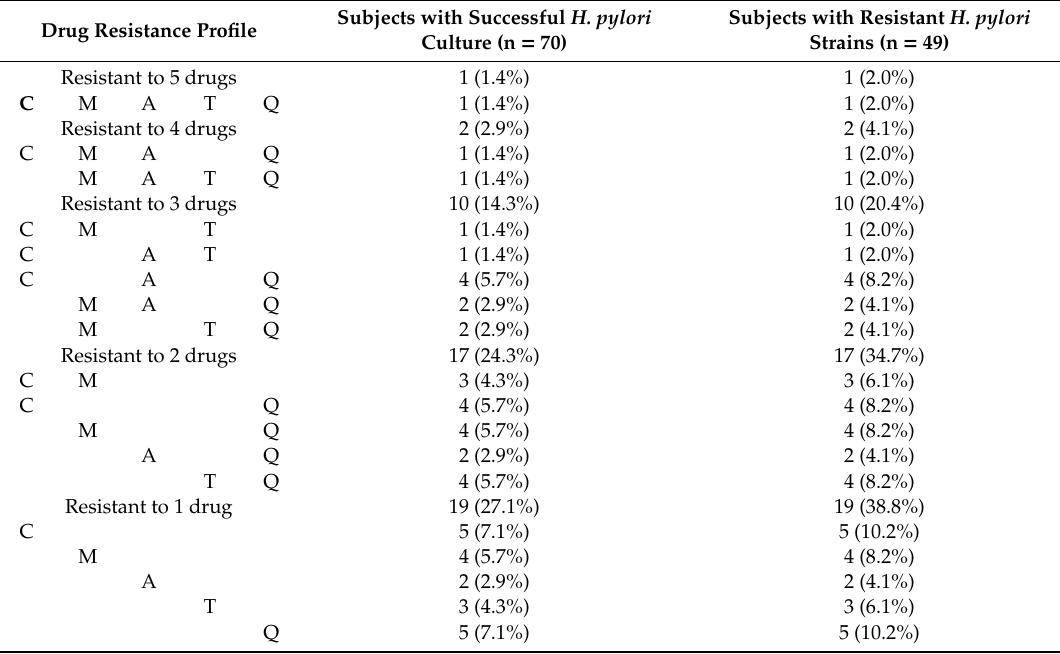
Table 2. Multidrug resistance profile of Helicobacter